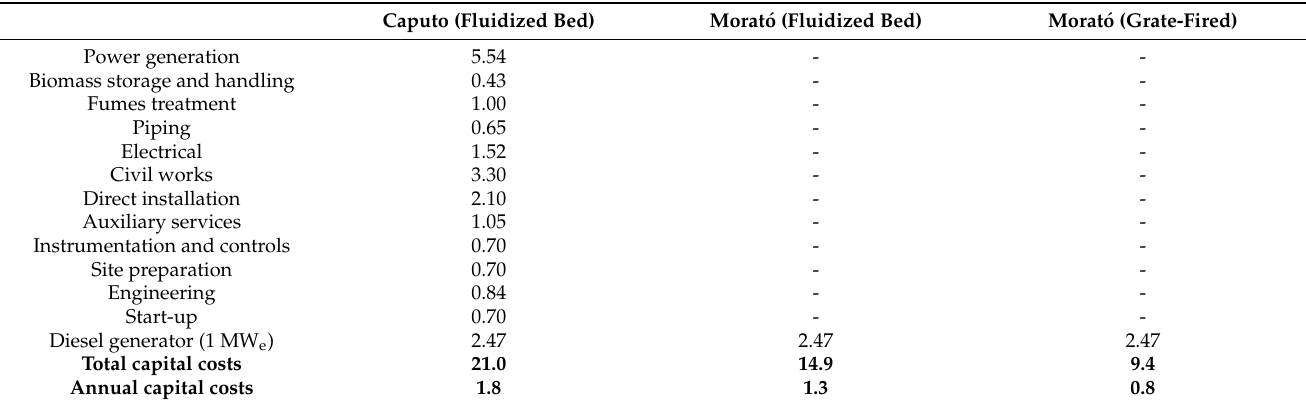
Table 4. Capital costs associated with running an electricity plant with directly combusted biomass. All costs are in AUD millions. The annual capital costs were calculated using Equation (2). (The calculations based on the work of Morat ó et al. only include the overall capital costs of direct combustion plant, hence why there are no line items).